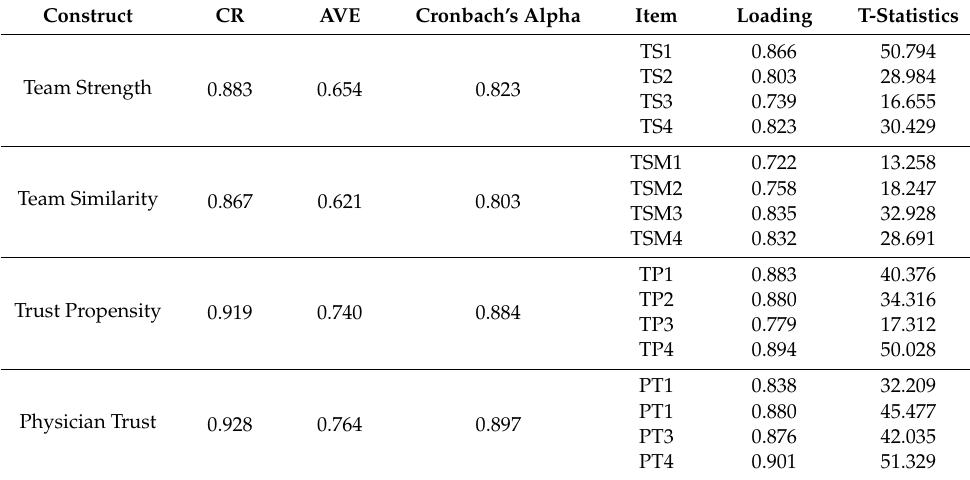
Table 3. Reliability and convergent validity.